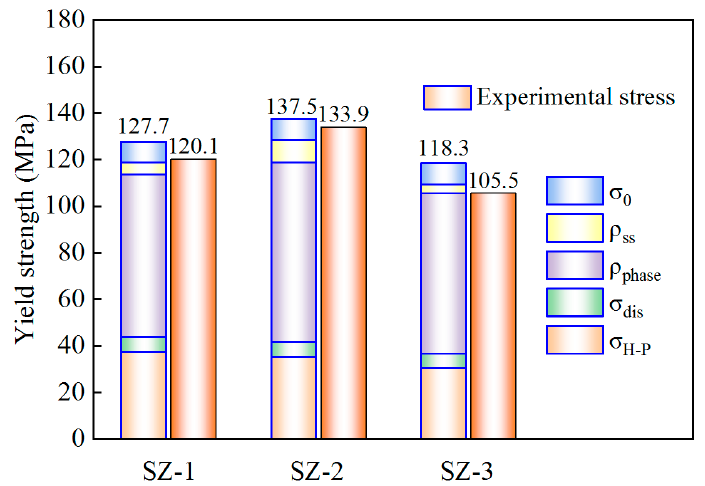
Figure 15. Comparison between experimental stress and calculated